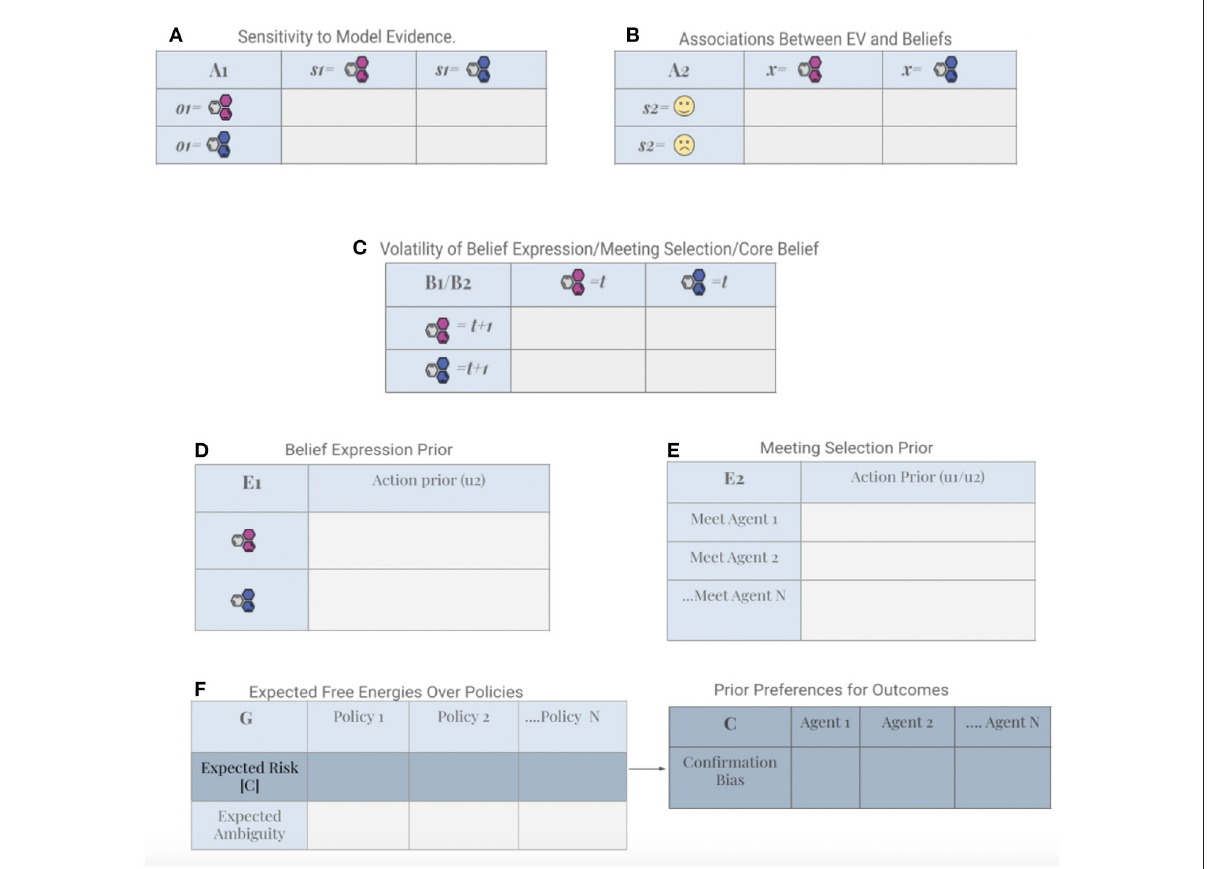
FIGURE3 Generative model parameters. (A) The A 1 matrix specifies an agents’ perception of an interlocutors’ expressed beliefs. The precision of this likelihood mapping determines the agent’s sensitivity to these expressions. (B) The A 2 matrix represents what the agent has learned about the mapping between her high and low level beliefs. (C) The B matrix, or state transition probabilities, represent what the agent has learned about how hidden states evolve over time. The precision of B matrices can be understood as encoding the volatility of belief states. (D) The E 1 matrix is one of two habitual contributions to action selection. It covers two possible outcomes for expressing beliefs. This contribution is specified on a continuous range between (0,1), where the extremes correspond to either complete confidence in denying or supporting the claim. (E) The E 2 matrix is the second habitual component for action, and it holds 50 possible outcomes for meeting selection (i.e., the probability for meeting each agent in the population). (F) The expected free energy of allowable policies (i.e., choices or actions) is indicated with G , which entails two components: 1. expected risk (the KL-divergence from the C matrix and biasing toward confirming one’s preferred ideas) and expected ambiguity, which biases toward meeting new agents with unknown beliefs. Note: The purpose of this Figure is to draw the attention of the reader to the general form of the matrices shared across the simulated agents. The tables are left empty because, for any individual agent in the simulated population, each of these objects contains specific numbers, which are initially generated procedurally from various probability distributions (described in the text) and change throughout the simulation as the agents interact in their shared environment. Specific numbers could at best describe only one particular agent at a given instance of time (which does not represent the entire population). Furthermore, the probability distributions used to generate initial values do not reflect the additional steps required such as, e.g., the renormalization procedures involved in applying a softmax operator. Finally, it would also occlude the fact that certain entries (e.g., the expected free energy) will vary over time during a